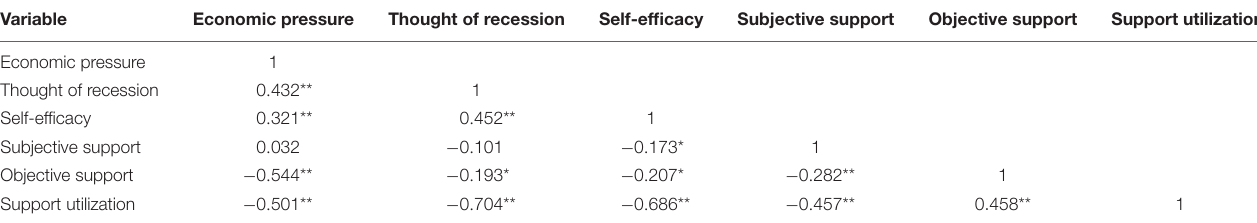
TABLE 5 | Correlation analysis on related variables of the thought of entrepreneurial